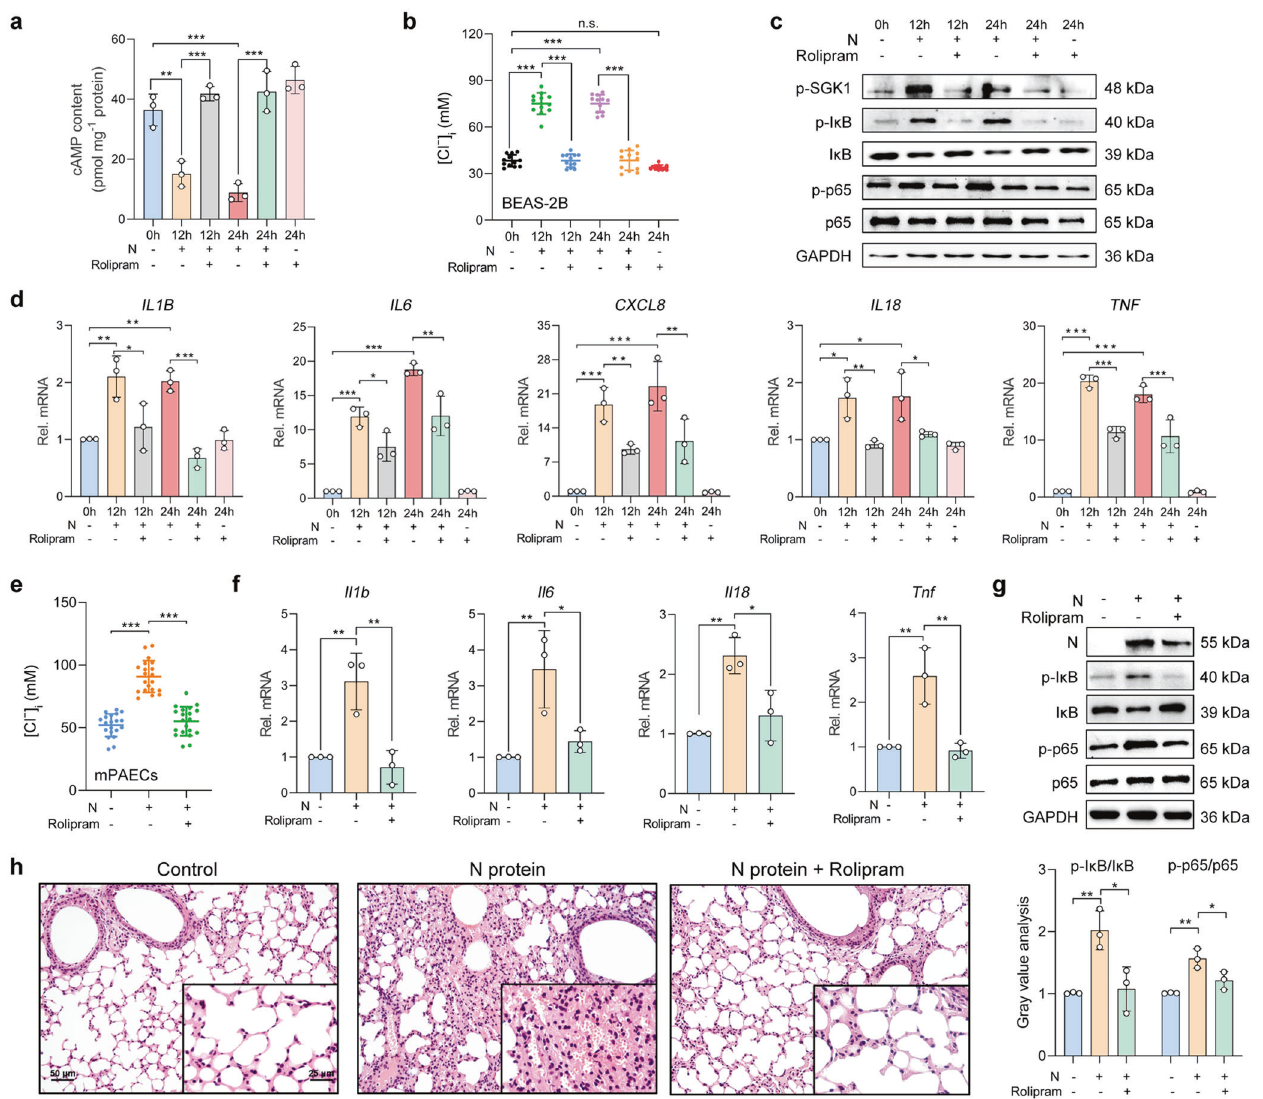
Fig. 6 Inhibition of PDE4 suppressed the SARS-CoV-2 N protein-induced ongoing in fl ammation via downregulation of the [Cl − ] i . a The effect of rolipram (20 μ M) on the intracellular cAMP content after the N protein (50 μ g/ml) stimulation in BEAS-2B cells ( n = 3). b The effect of rolipram (20 μ M) on [Cl − ] i in BEAS-2B cells stimulated with the N protein (50 μ g/ml) ( n = 12 cells). c The effect of rolipram (20 μ M) on phosphorylation level of SGK1, I κ B, and NF- κ B p65 subunit after N protein (50 μ g/ml) stimulation in BEAS-2B cells. d The effect of rolipram (20 μ M) on the mRNA expression levels of pro-in fl ammatory cytokines stimulated with the N protein (50 μ g/ml) in BEAS-2B cells ( n = 3). e The effect of rolipram (10 mg/kg) on [Cl − ] i in mPAECs from mice after N protein (0.25 mg/kg) stimulation ( n = 20 cells). f The effect of rolipram (10 mg/kg) on the expression levels of cytokines stimulated with the N protein (0.25 mg/kg) in mice ( n = 3). g The effect of rolipram (10 mg/kg) on the phosphorylation level of I κ B and p65 after N protein (0.25 mg/kg) stimulation in mice, with the gray value analysis ( n = 3). h H&E staining of lung slices from N protein (0.25 mg/kg)-stimulated mice with or without treatment with rolipram (10 mg/kg). Scale bars, 50 μ m and 25 μ m. Data were shown as mean ± SD, * P < 0.05, ** P < 0.01, *** P < 0.001, n.s. P >